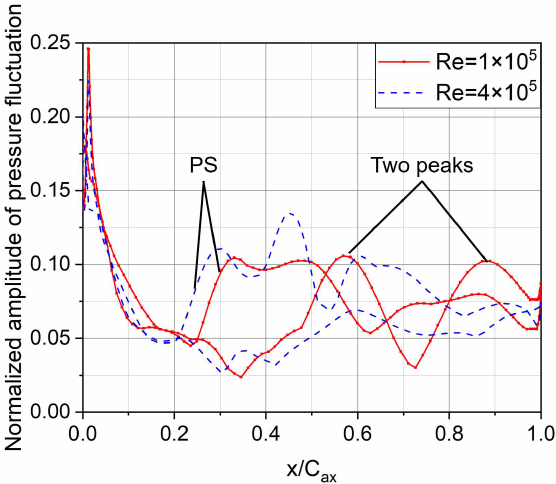
Figure 20. Amplitude of pressure fluctuation on the rotor surface at 99% span.